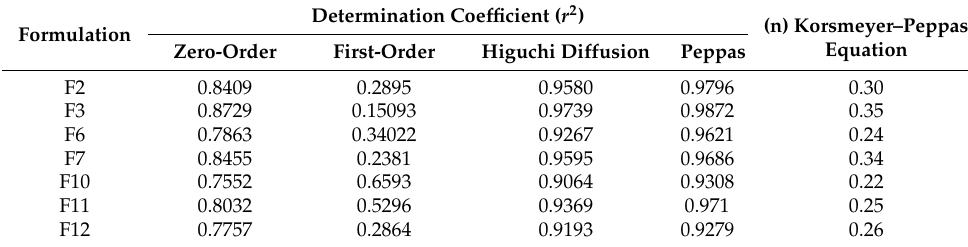
Table 2. Kinetics of DEX release from different in situ gel formulations according to different kinetic models.